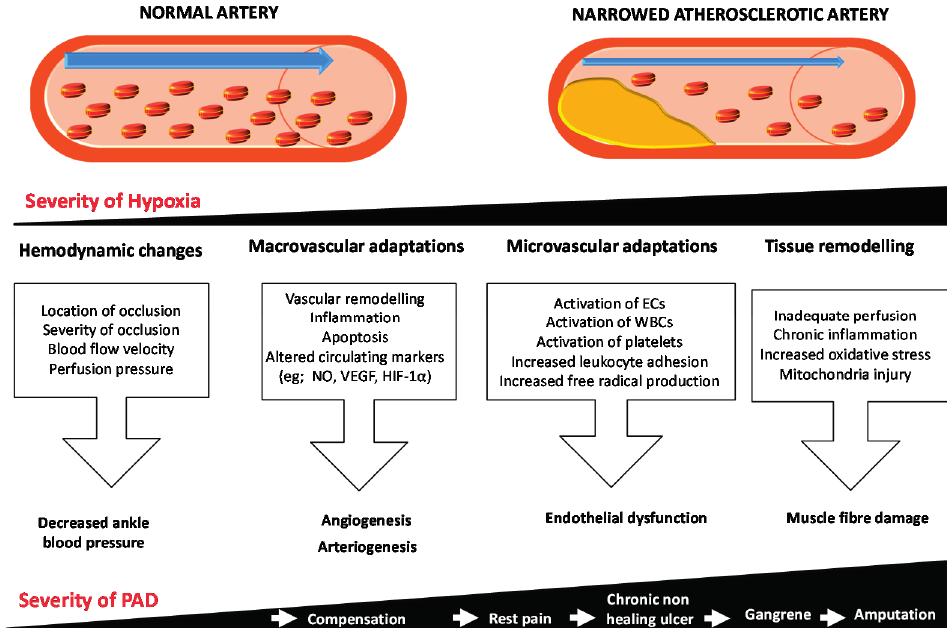
Figure 1. Schematic representation of the response to ischemia in peripheral artery disease. Initially the ischemic limb tries to compensate and resolve the hypoxia by changing the hemodynamics and promoting microvascular adaptations by promoting angiogenesis and/or arteriogenesis. As the severity of the hypoxia increases, the microvascular adaptations are not able to compensate. All these changes lead to mitochondrial injury and free radical generation and subsequent muscle fibre damage, myofibre degeneration and fibrosis. These changes eventually result in decreased oxygen supply and increased metabolic demands leading to conditions such as rest pain, chronic non-healing wounds and gangrene, subsequently threatening the limb function and viability. Blue arrows show the direction of blood flow in the artery and white arrows shows the increase in severity of disease. Abbreviations: ECs, endothelial cells; HIF-1 α , Hypoxia inducible factor-1 α ; NO, Nitric oxide; PAD, Peripheral artery disease; VEGF, Vascular endothelial growth factor WBCs, white blood